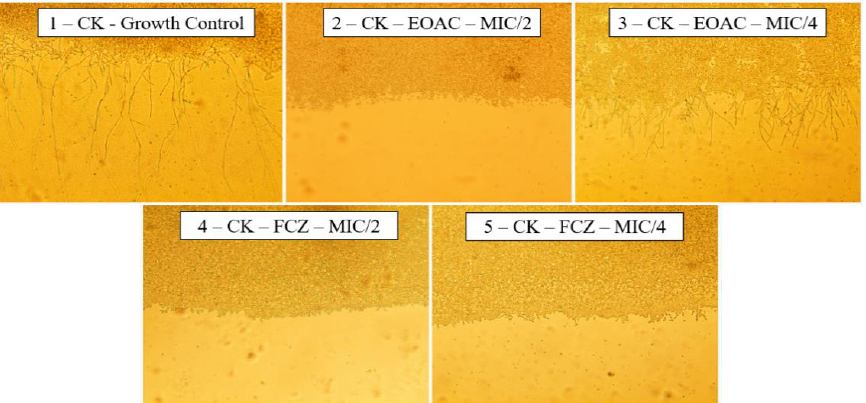
Figure 5. Effects of Acritopappus confertus essential oil on the morphological aspects of Candida krusei . Slide (S1): Growth control; (S2): Effect of essential oil at a concentration of 512 µg/mL; (S3): Effect of essential oil at a concentration of 256 µg/mL; (S4): Effect of fluconazole at a concentration of 512 µg/mL; (S5): Effect of fluconazole at a concentration of 256 µg/mL. Display 400× enlarged. The C. tropicalis strain was sensitive to all treatments analyzed, with no observable growth of hyphae in the concentrations of 1024 µg/mL and 512 µg/mL of A. confertus es- sential oil (S2, S3), nor in the positive control fluconazole at concentrations of 1024 µg/mL and 512 µg/mL (S4, S5) (Figure 6). In the growth control (S1) using only nutrient-depleted culture medium, it was possible to observe the projections of hyphae and pseudohyphae of C. tropicalis .